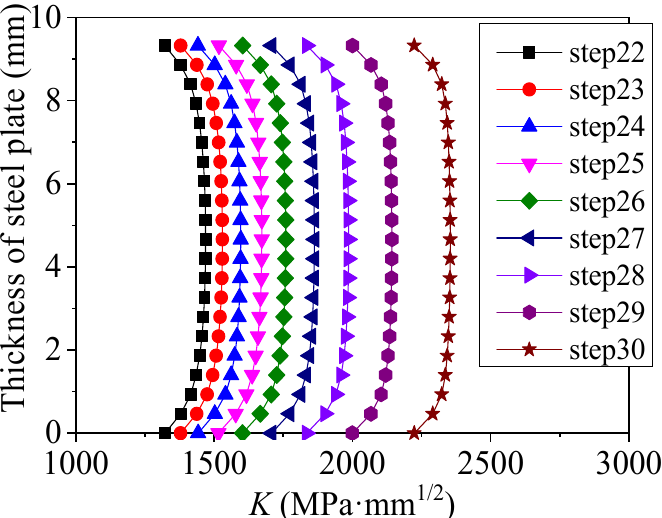
Figure 12. Distribution of tensile stress along the crack front of specimen C9-DS1-A during through crack propagation stage (unit: MPa): ( a ) step 22, ( b ) step 24, ( c ) step 26, and ( d ) step 28.